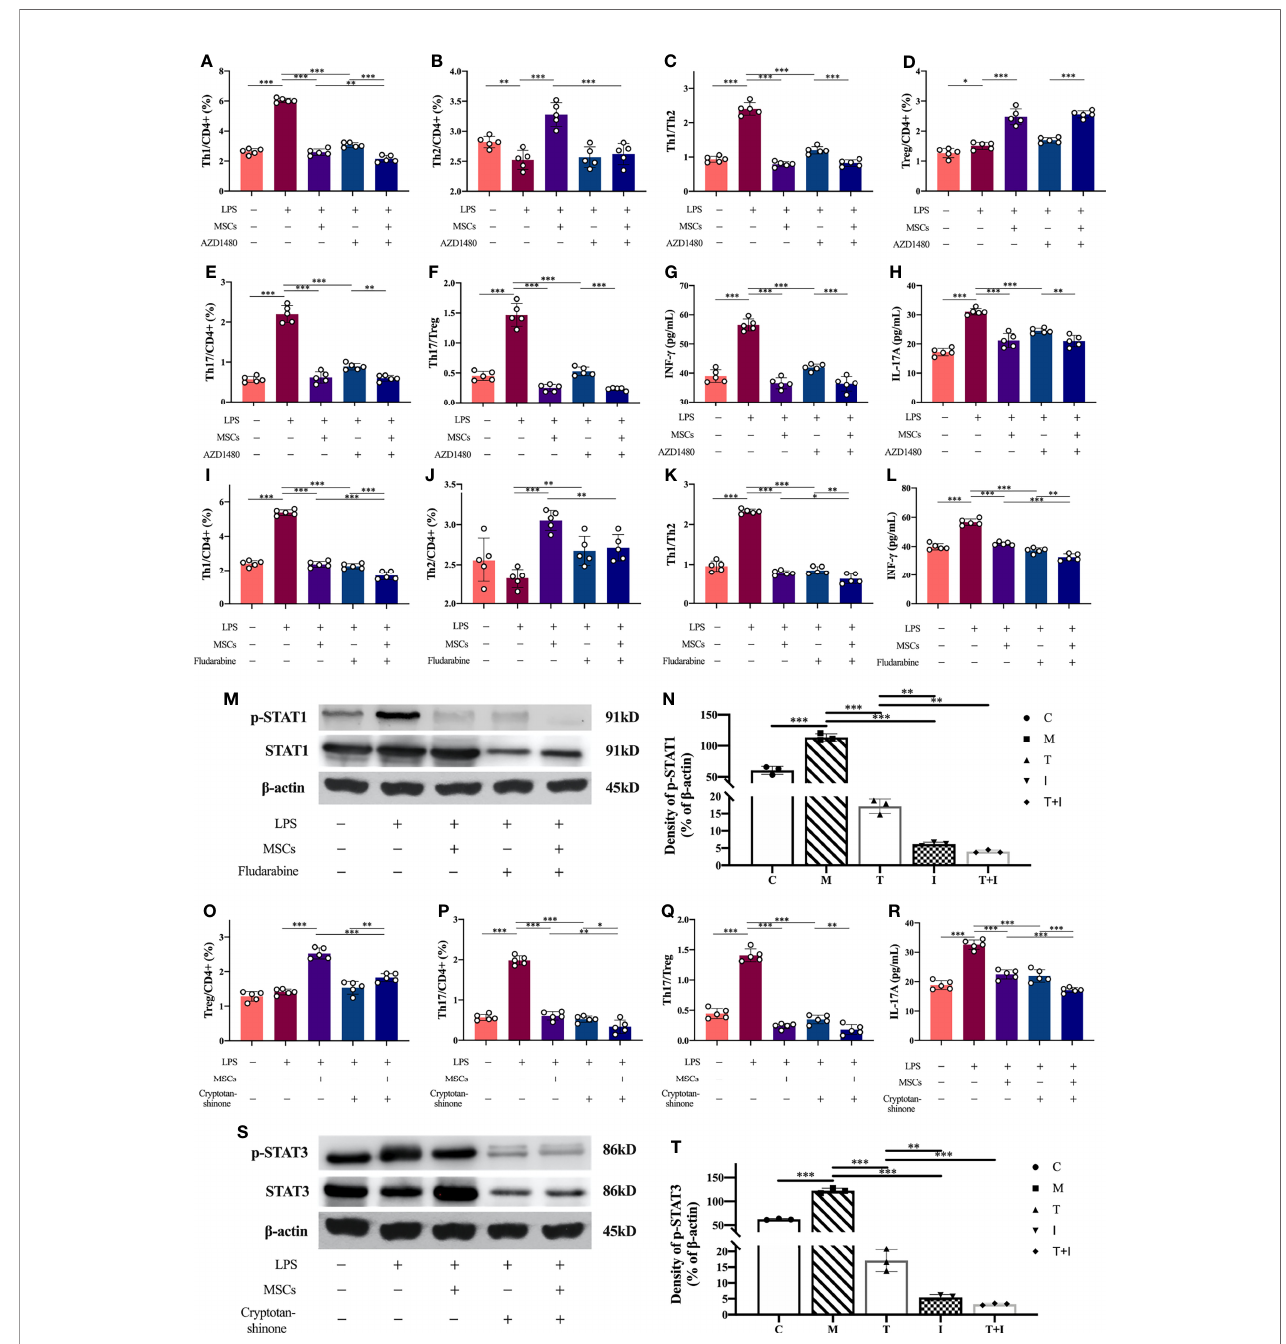
FIGURE 7 | Levels of in fl ammatory factors in cell supernatants and the proportion of Th cells in lymphocytes and the expression levels of STAT1 and STAT3 in each group after the use of inhibitors. Lymphocytes isolated from rat spleen were co-cultured with MSCs at a ratio of 10:1, and the inhibitors used and the co-culture time was 24hours. The concentrations of the inhibitors used in the experiment were AZD1480 (5 m M), fl udarabine (100 m M) and cryptotanshinone (50 m M). (A – F) Proportions of Th1, Th2, Th17 and Treg cells in CD4+ T cells and the ratios of Th1/Th2 and Th17/Treg in each experimental group after the use of JAK inhibitors (n=5); (G) levels of IFN- g in the supernatant of each experimental group after the use of JAK inhibitors (n=5); (H) levels of IL-17A in the supernatant of each experimental group after the use of JAK inhibitors (n=5); (I – K) Proportions of Th1 and Th2 cells in CD4+ T cells and Th1/Th2 ratio in each experimental group after using STAT1 inhibitor (n=5); (L) levels of IFN- g in cell supernatants in each experimental group after using STAT1 inhibitor (n=5); (M, N) expression levels of STAT1 and p-STAT1 in lymphocytes in each experimental group and the results of semi-quantitative analysis (n=3); (O – Q) Proportions of Th17 and Treg cells to CD4+ T cells and Th17/Treg ratio in each experimental group after using STAT3 inhibitor (n=5); (R) Levels of IL-17A in cell supernatants of each experimental group after using STAT3 inhibitor (n=5); (S, T) Expression levels of STAT3 and p-STAT3 in lymphocytes of each experimental group and the results of semi-quantitative analysis (n=3). *p<0.05, **p<0.01, ***p<0.001; C, control group; M, model group; T, treatment group; I, inhibitor group; T+I, inhibitor+MSCs